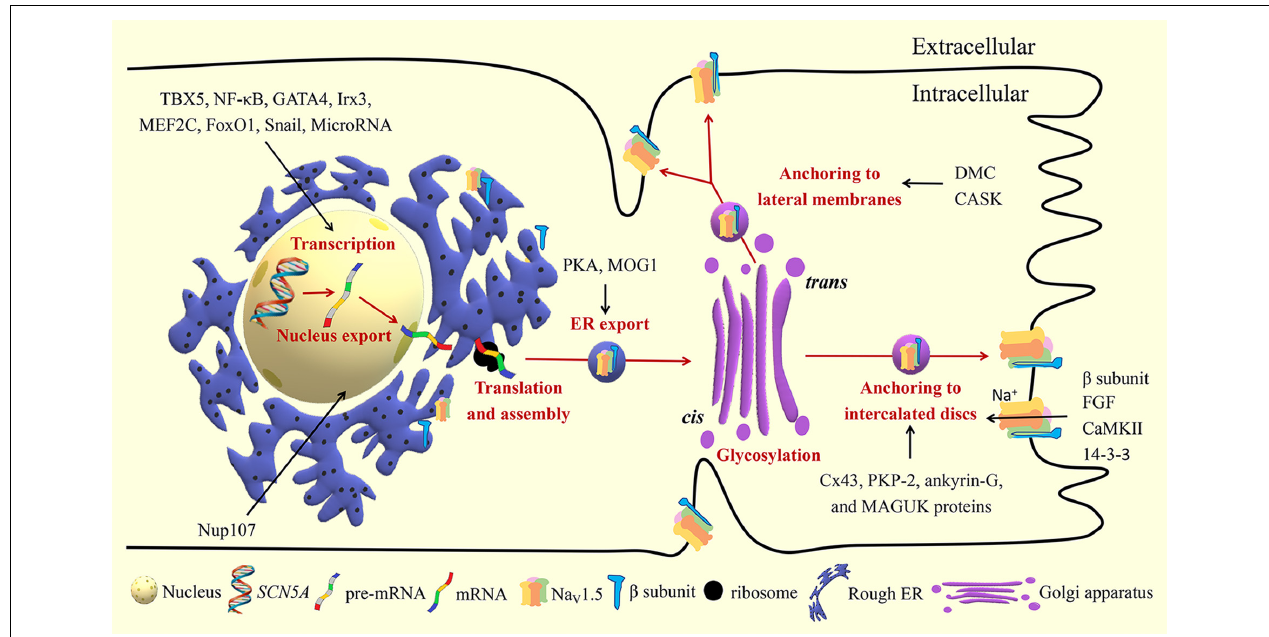
FIGURE 2 | Biosynthesis and trafficking of Na V 1.5. TBX5, T-box transcription factor 5; NF- κ B, nuclear factor kappa-B; Irx3, Iroquois homeobox 3; MEF2C, myocyte enhancer factor-2C; Forkhead box O1; Nup107, nucleoporin 107; PKA, protein kinase A; Cx43, connexin 43; PKP-2, plakophilin 2; MAGUK, membrane-associated guanylate kinase; DMC, dystrophin-syntrophin multiprotein complex; CASK, calcium/calmodulin-dependent serine protein kinase; FGF, fibroblast growth factor; CaMKII, Ca 2 + / calmodulin-dependent kinase II.